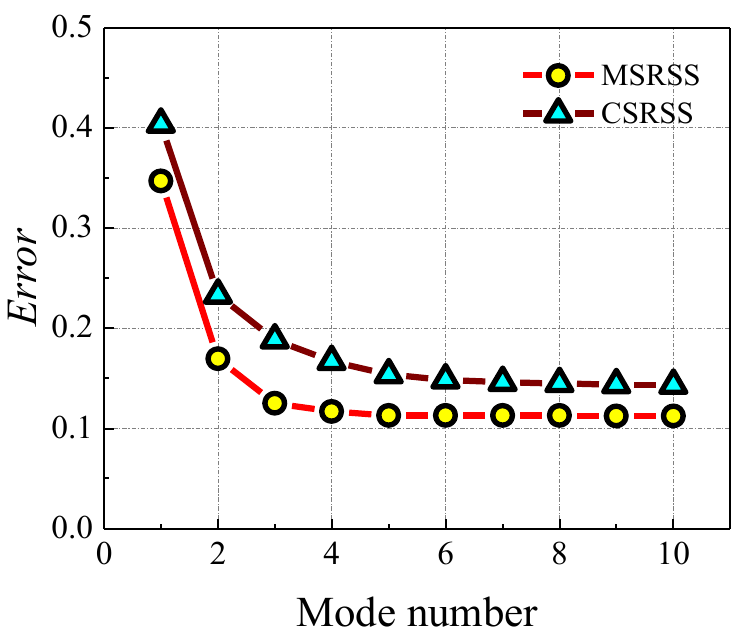
Figure 8. Resulting Error of optimal process using a different number of modes. Table 1. Weighting coefficients A n for the first three